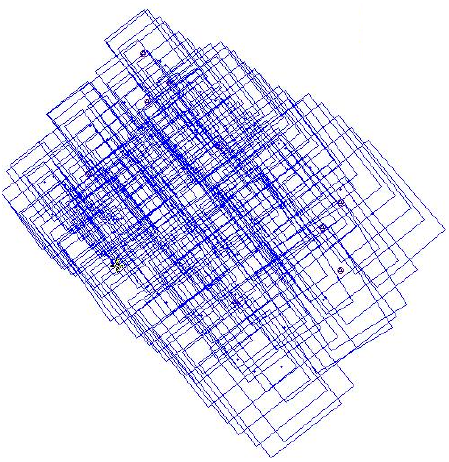
Figure 8. The footprint of used thermal images in this study.